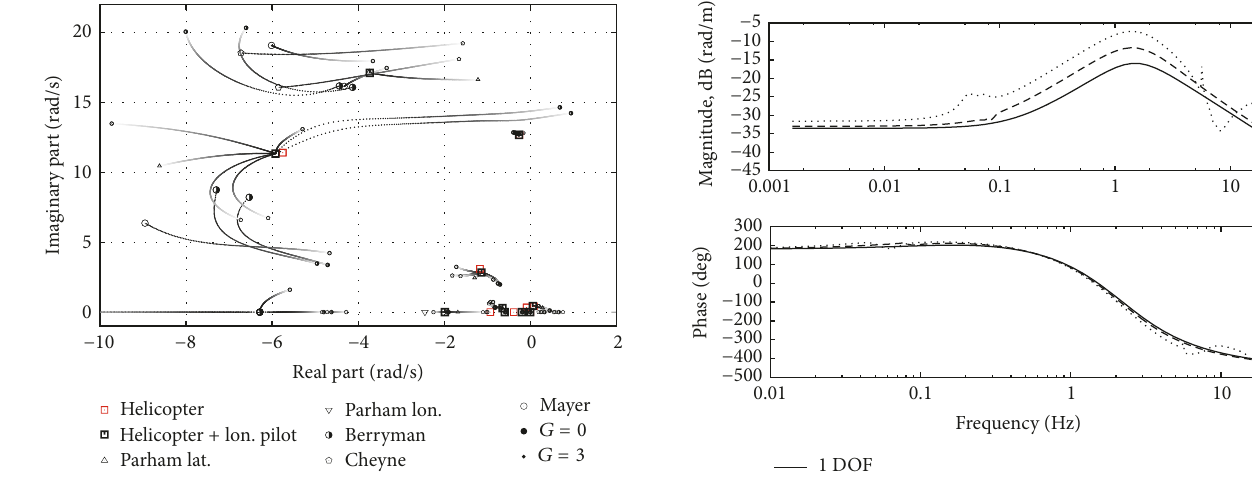
Figure 13: Effects of longitudinal pilot-in-the-loop on root loci, for gearing ratio increase.